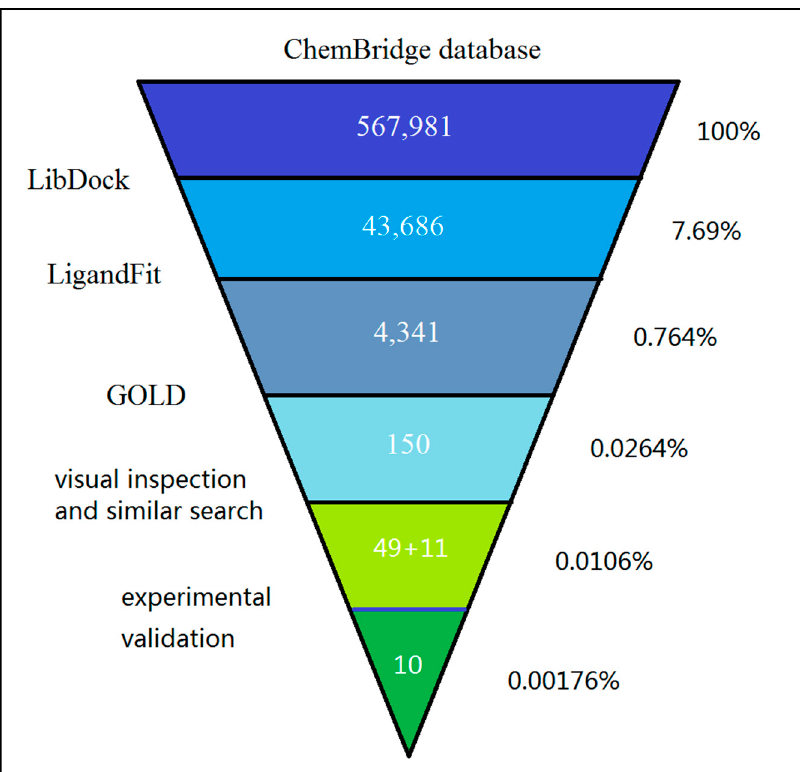
Figure 1. Workflow of the cascade docking virtual screening of ChemBridge database targeting influenza PB2 CBD.